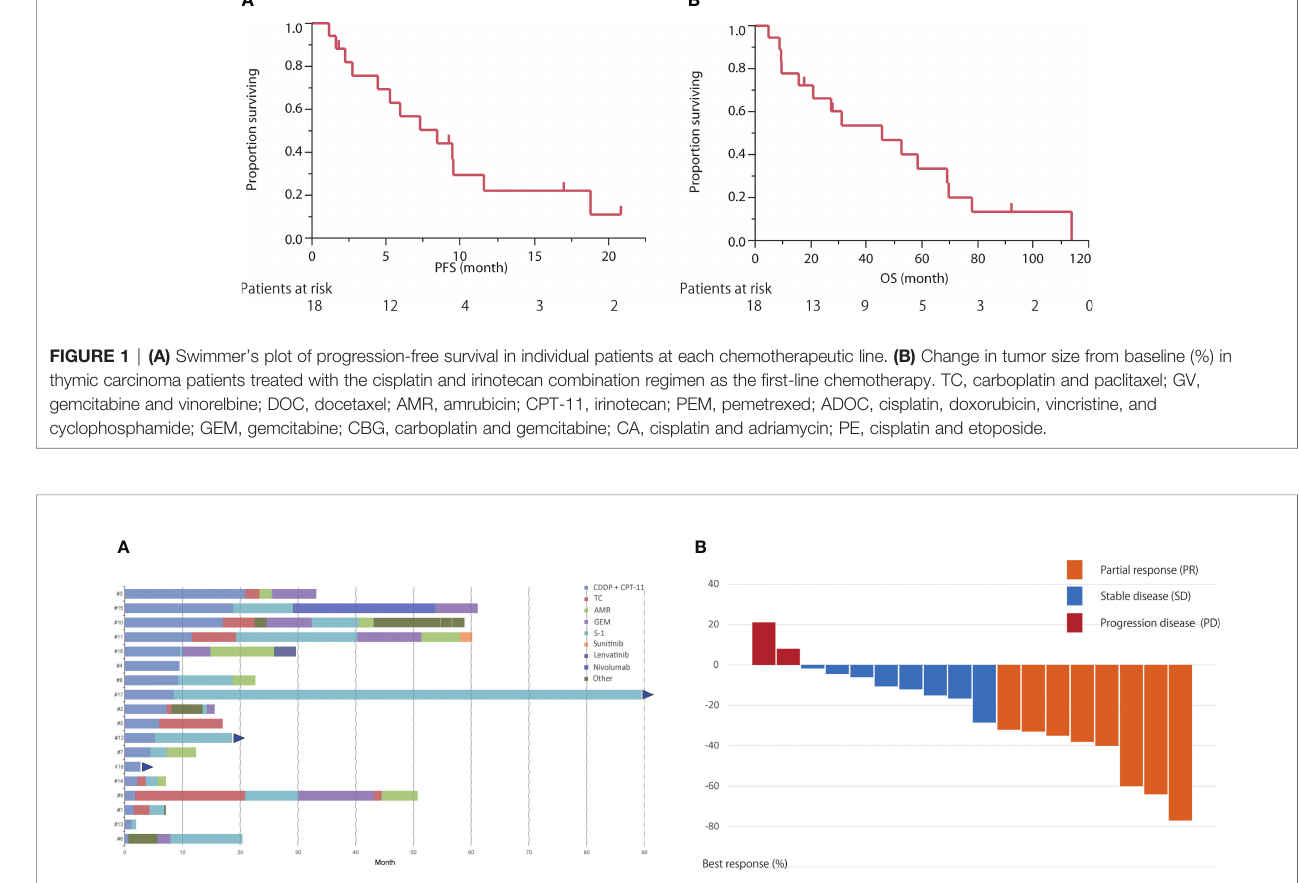
FIGURE 2 | (A) Progression-free survival and (B) overall survival for 18 patients with unresectable thymic carcinoma who received cisplatin and irinotecan combination